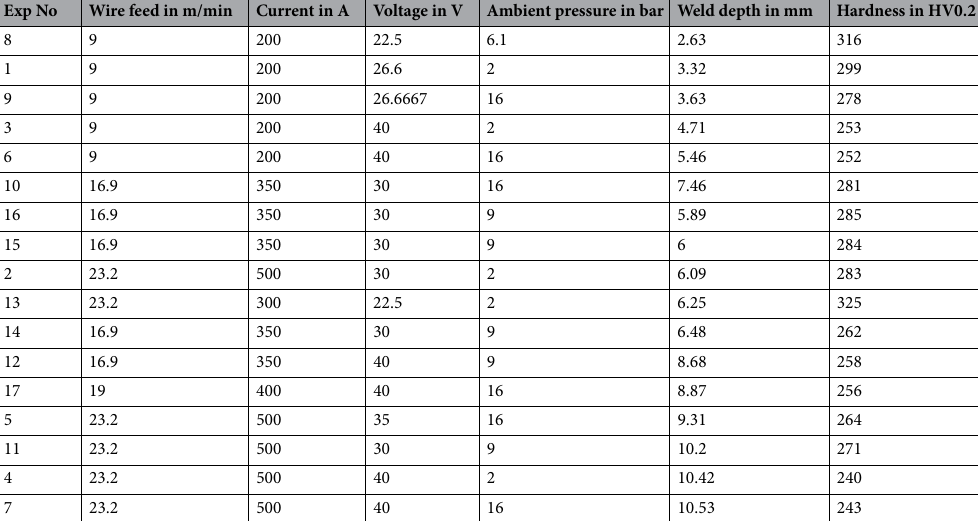
Table 4. Design of experiments with results for weld depth.